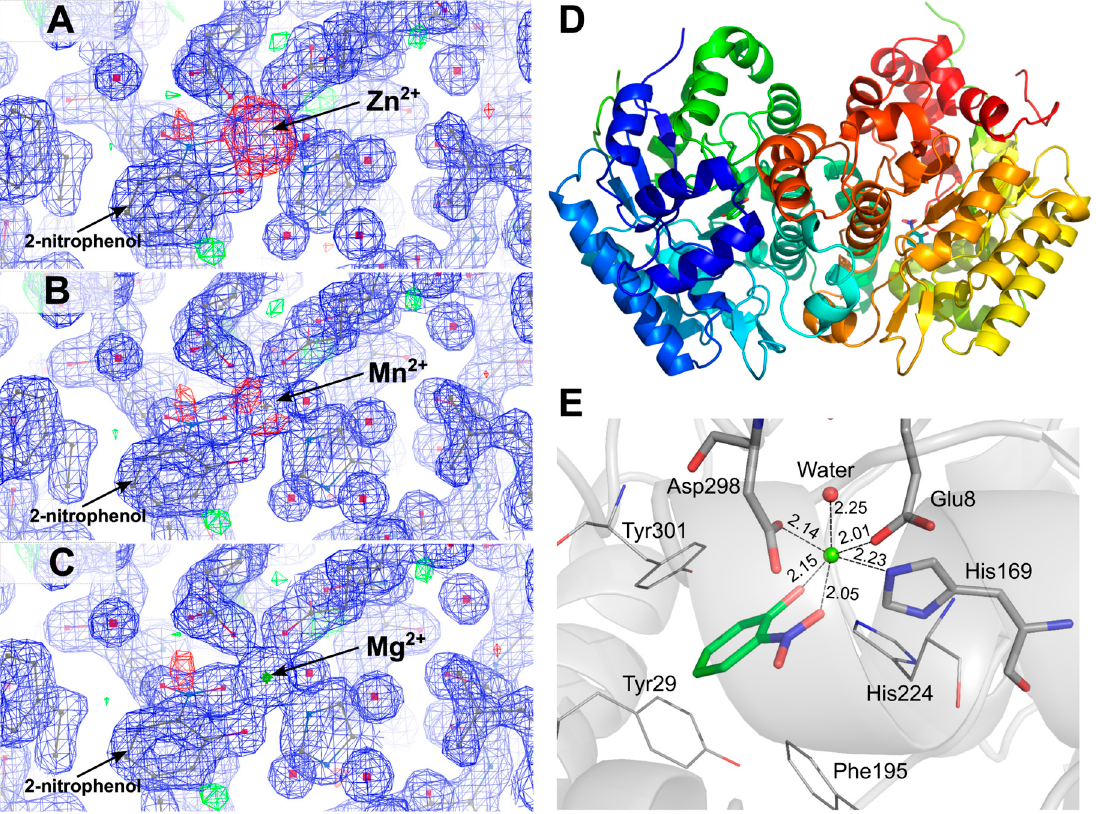
Figure 5. Electron density map (2F obs -F calc ) of models with ( A ) Zn 2+ , ( B ) Mn 2+ , or ( C ) Mg 2+ in blue, contoured at 1.5 sigma, and the difference map (F obs -F calc ) is at 3.0 sigma. The B factors at full occupancy are 44.05 (Chain A) and 43.32 (Chain B) for Zn 2+ , 36.64 (Chain A) and 36.69 (Chain B) for Mn 2+ , and 16.79 (Chain A) and 16.97 (Chain B) for Mg 2+ . The average B factor for all atoms of the structure is 18.53, and the average B factor for all atoms of the ligand is 18.94. ( D ) Overall structure and ( E ) active site structure of SDC in complex with 2-nitrophenol (PDB ID: 8H41).